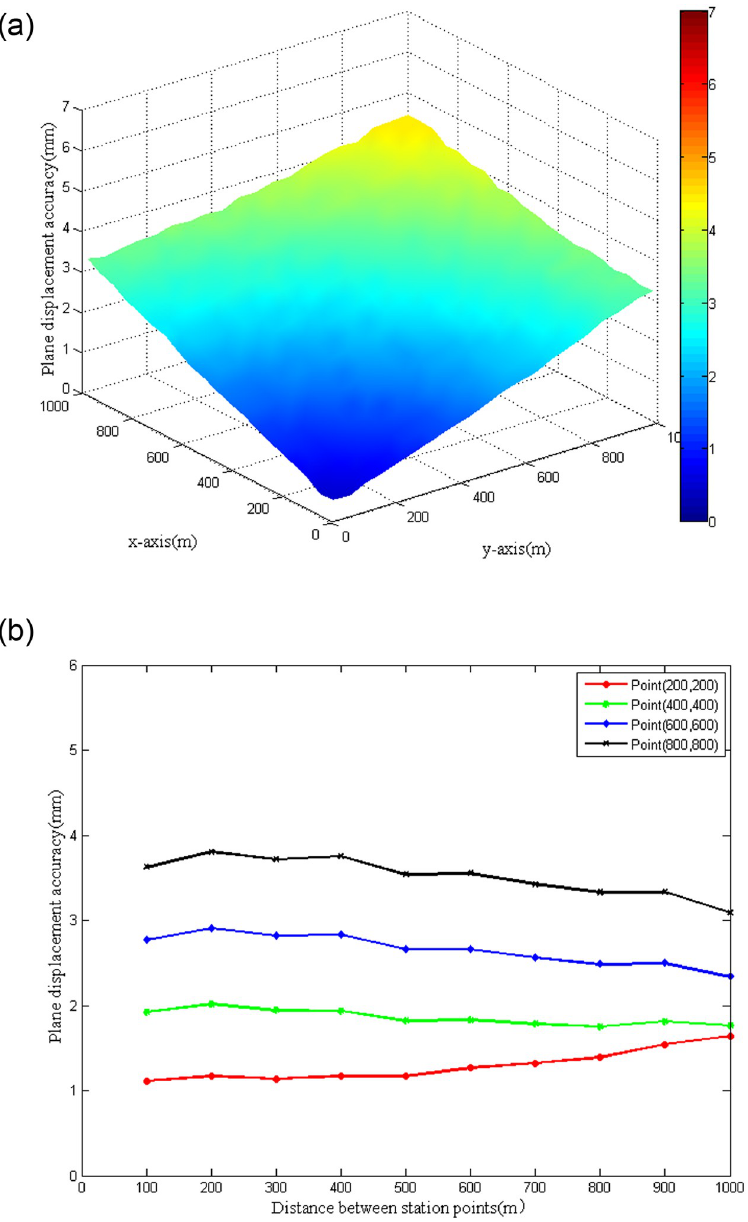
Fig 5. Plane displacement accuracy with the forward intersection method. (a) 100 m between station points. (b) Different distances between station points.